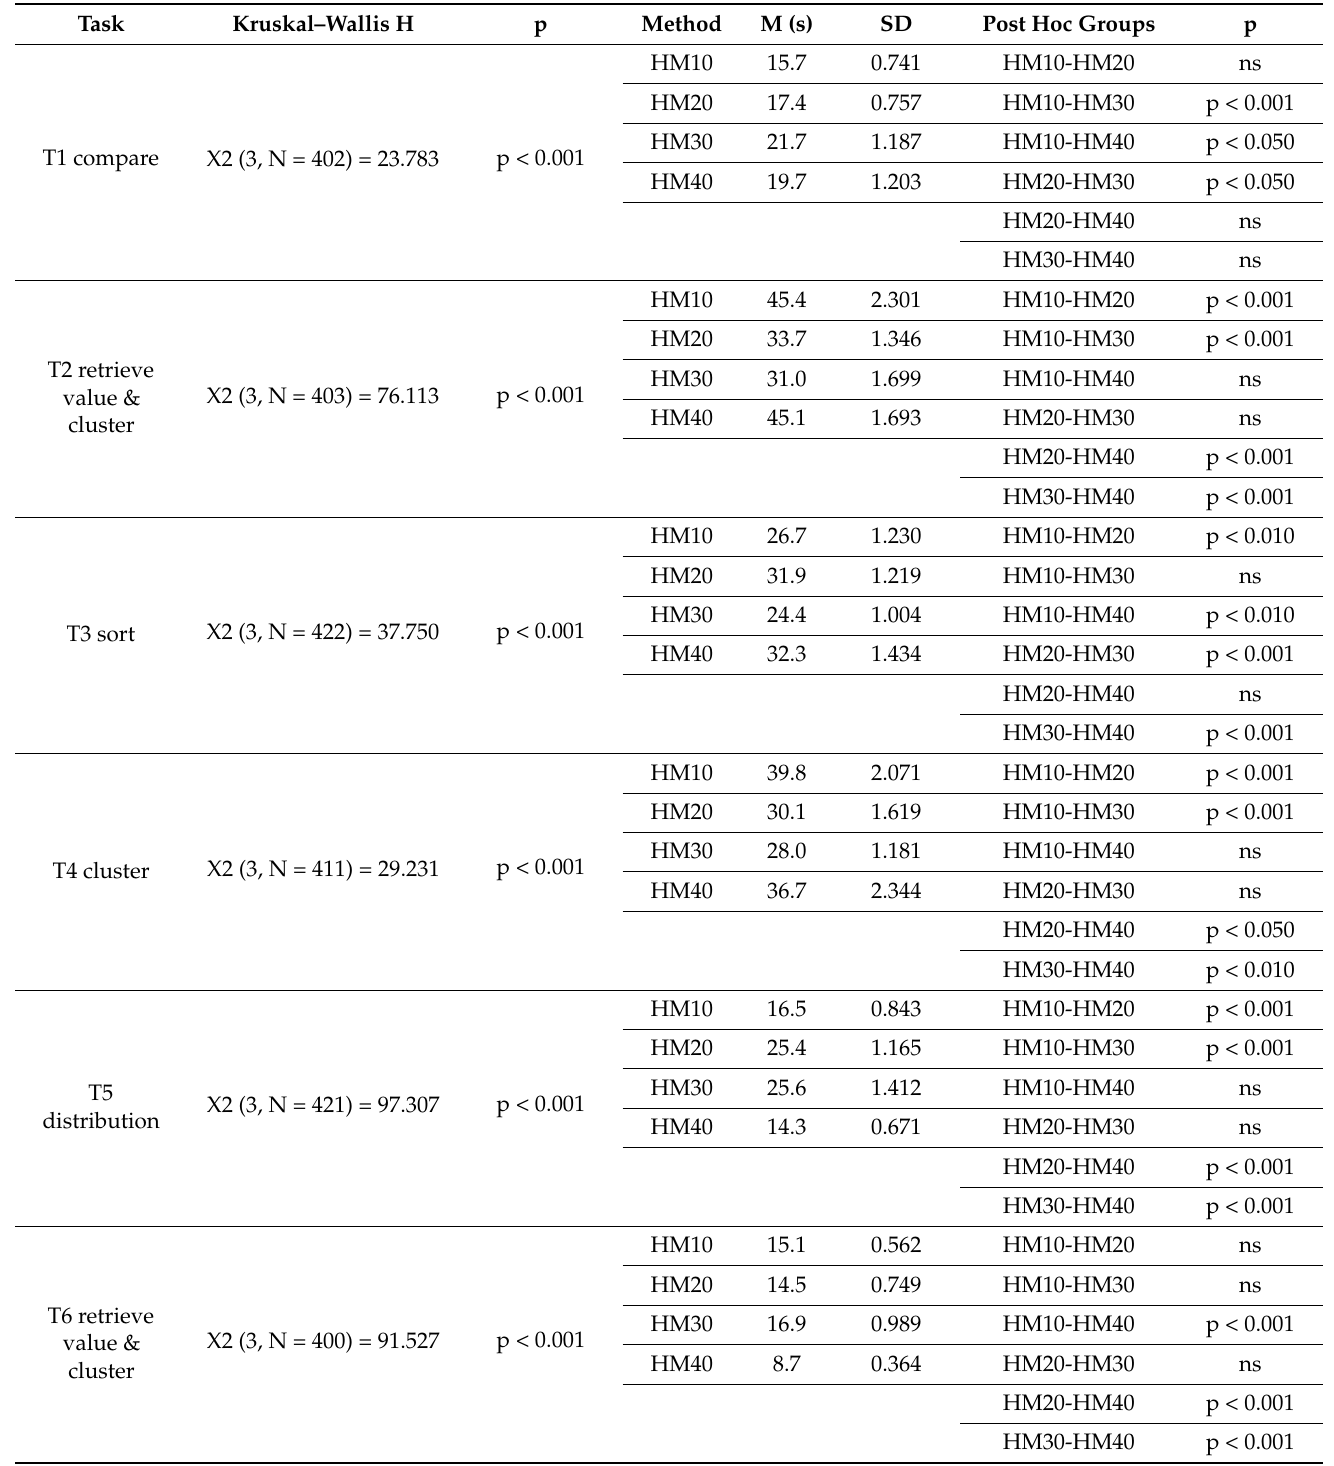
Table 4. Inferential statistics between participants using the four tested heat